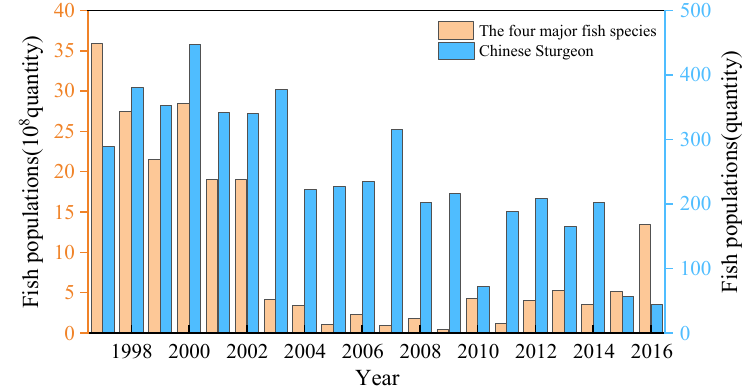
Figure 13. Breeding of major fishes in the Yangtze River.